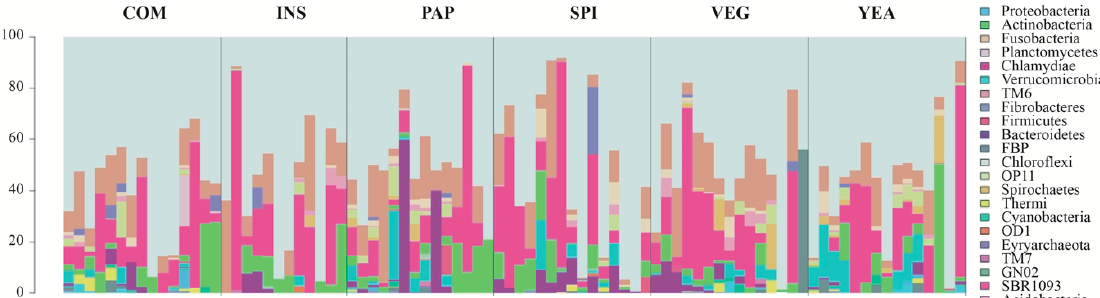
Figure 5. Relative abundances (%) of the 22 phyla identified in all samples of the different dietary groups shows a high variability of the gut microbiome among individual fish fed the different diets ( n = 12 to 16 fish/diet). Top: fish feed formulations used in this study: COM (conventional commercial feed control), INS (85% VEG + 15% insect), PAP (85% VEG + 15% poultry blood and feather), SPI (85% VEG + 15% cyanobacteria), VEG (100% terrestrial plants), and YEA (85% VEG + 15% yeast).